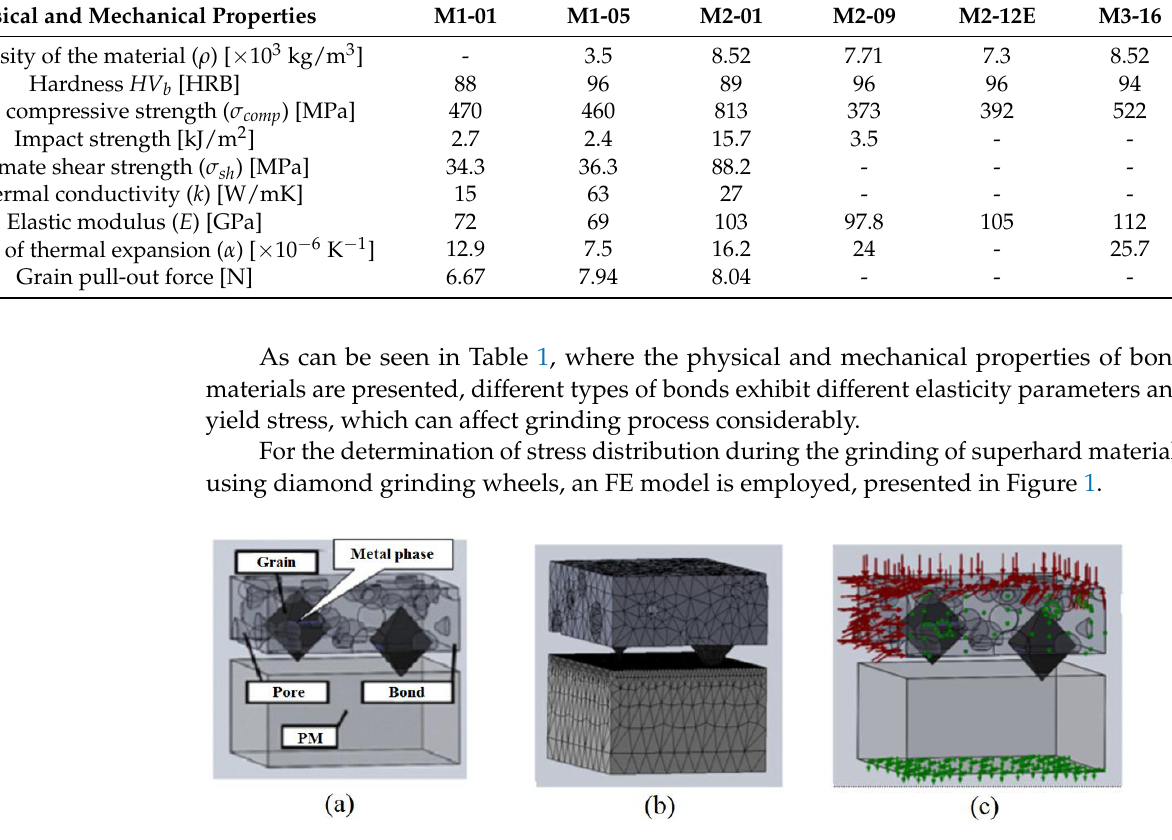
Figure 1. ( a ) FE model geometry employed for the determination of stress distribution during contact of diamond abrasive wheel and superhard material workpiece, ( b ) grid of the FE model, and ( c ) boundary conditions.